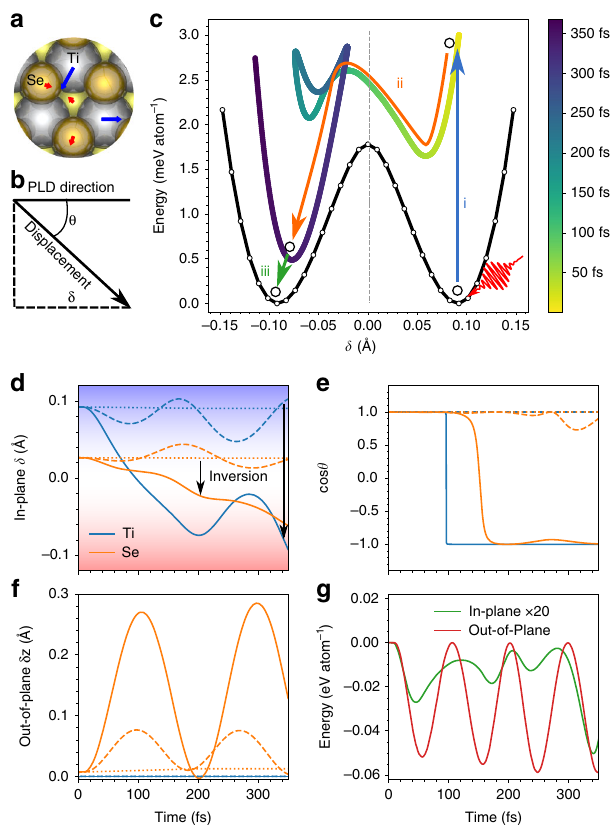
Fig. 4 Photoexcited lattice dynamics . a All the symmetrically inequivalent atoms with nontrivial PLD. b The illustration of δ and θ . c The potential energy surfaces (PES). The black and colored lines denote the ground state PES and the non-equilibrium TD-PES, E ½ δ ð t Þ(cid:4) , respectively. The d δ ð t Þ , e cos θ ð t Þ , and f δ z ð t Þ as a function of time. g The minus of the kinetic ð t Þ and in-plane movements energies of out-of-plane movements (cid:3) E kin (cid:3) E ð t Þ as a function of time. The solid, dash and dotted lines denote the kout I ¼ I = 4, and the quenched case ( I ¼ I , I ¼ I but with 1.4% energy 0 0 0 dissipation),